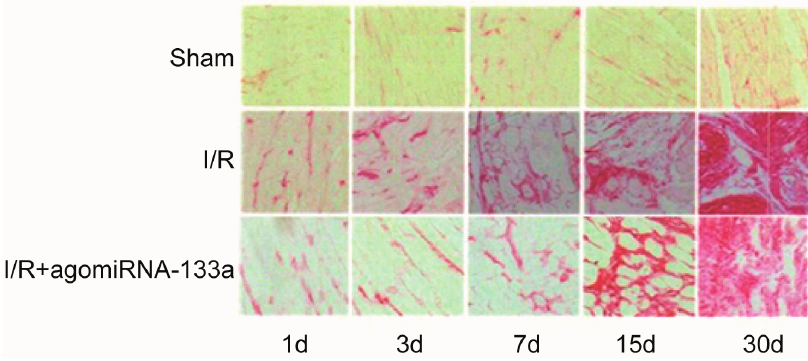
Figure 2. Degree of myocardial fibrosis of three groups at various time points.